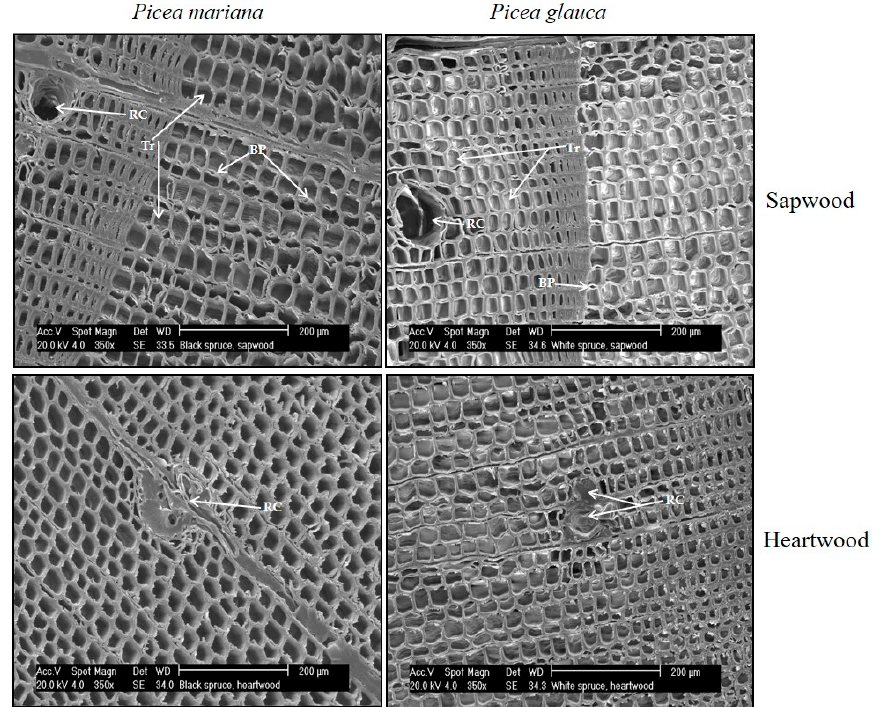
Figure 2. Scanning electron micrographs of Picea mariana and Picea glauca stems tissues. The sapwood micrographs for both species show open resin canals (RC) and bordered pits (BP) between tracheids (Tr). Notice that the resin canals are clogged in the heartwood tissues.